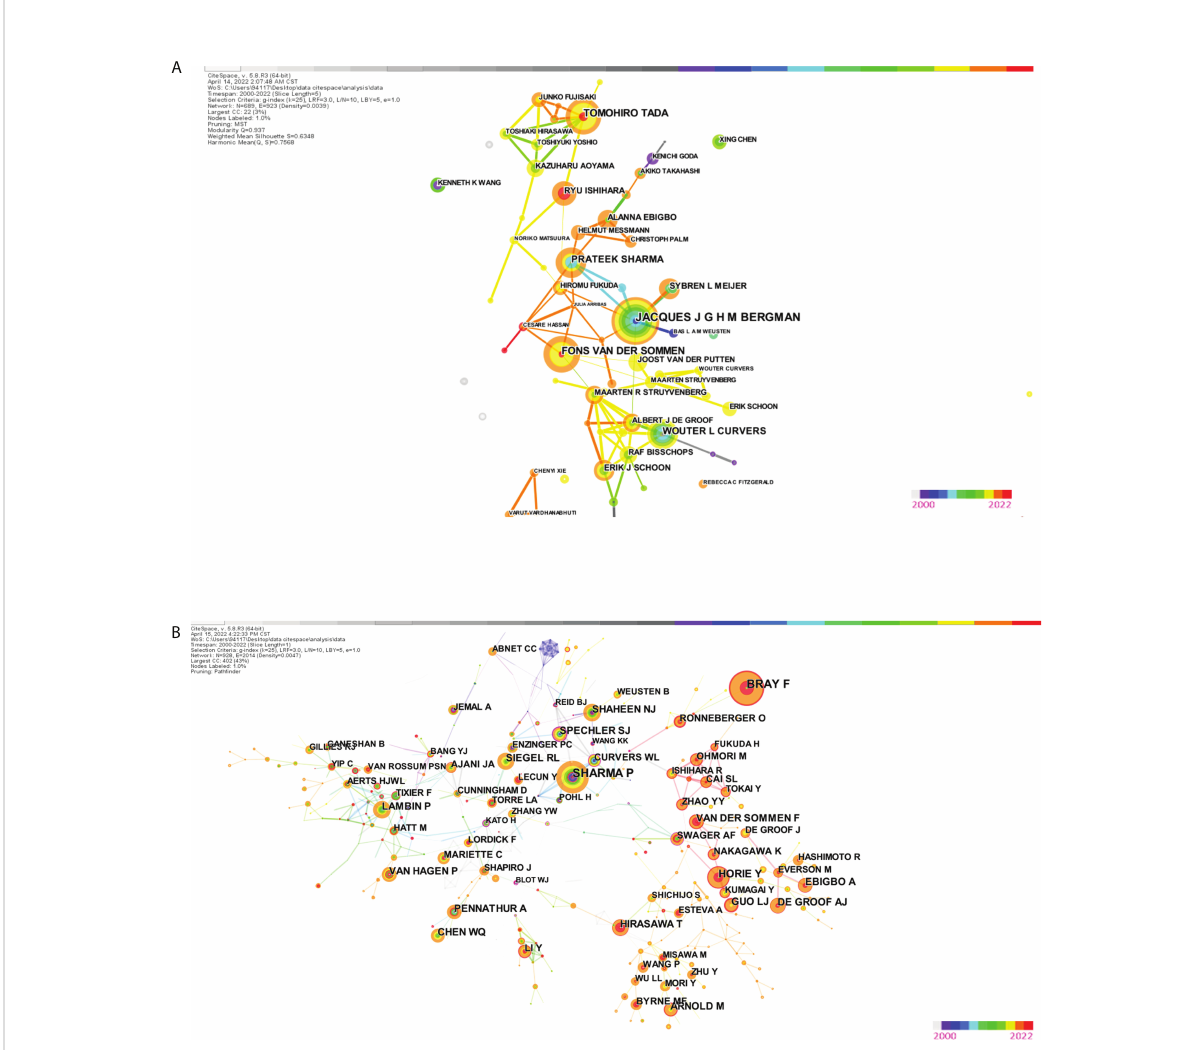
FIGURE 6 (A) The visualization map of co-authorship carried on CiteSpace. (B) The visualization map of co-citation (cited author) carried on CiteSpace.